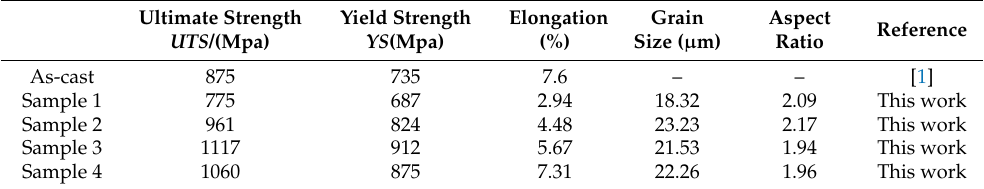
Table 4. Mechanical properties of the LPBF-manufactured K418 samples at room